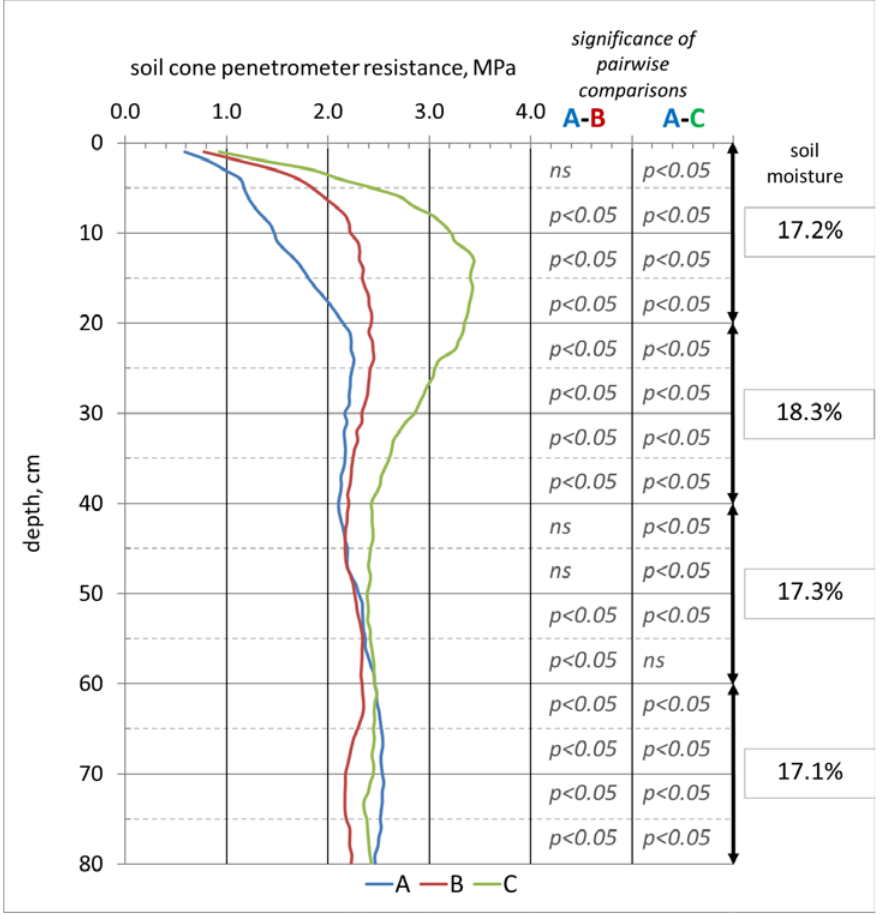
Figure 11. Soil cone penetrometer resistance measured in October 2021 (A—no traffic; B—single pass; C—multiple passes/permanent tramlines) and comparison of differences between the areas (one way ANOVA, α = 0.05; ns = not significant).